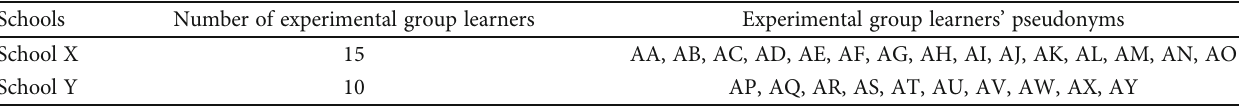
Table 2: Distribution of experimental group learners.